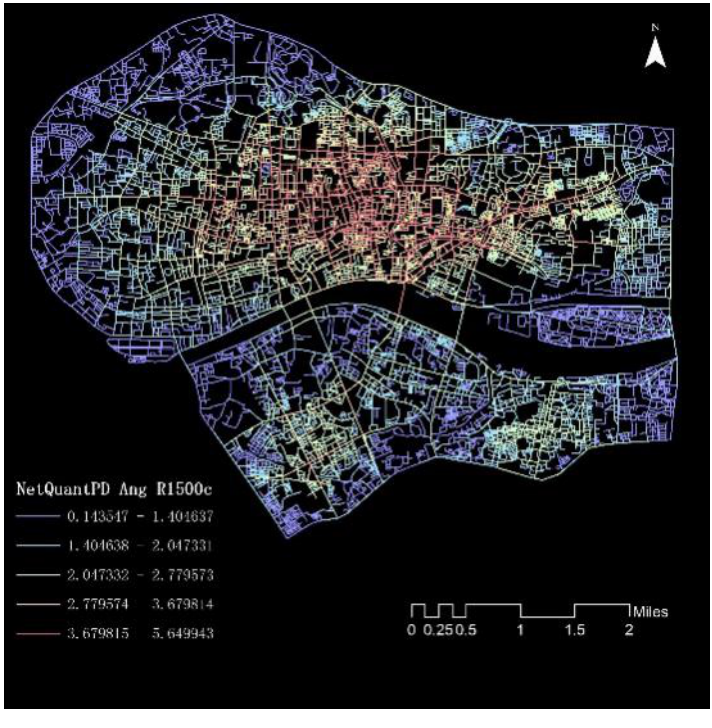
Fig. 6 The regional closeness of 1500m radius